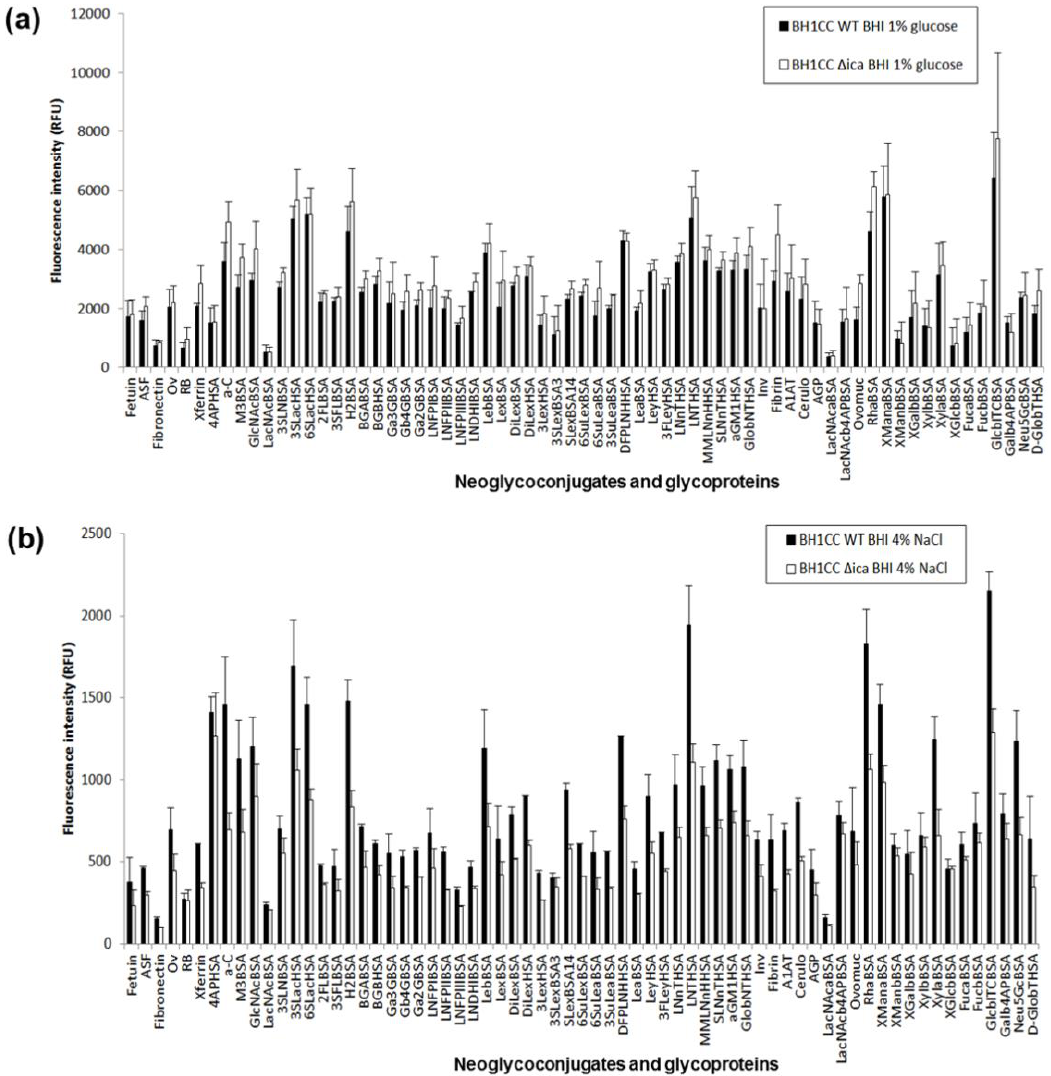
Figure 4. Carbohydrate microarray binding intensity profiles of S. aureus BH1CC WT and ∆ ica grown in BHI supplemented with ( a ) 1% glucose and ( b ) 4% NaCl. Bars represent the mean of three experiments with error bars of +/-1 SD of the mean.